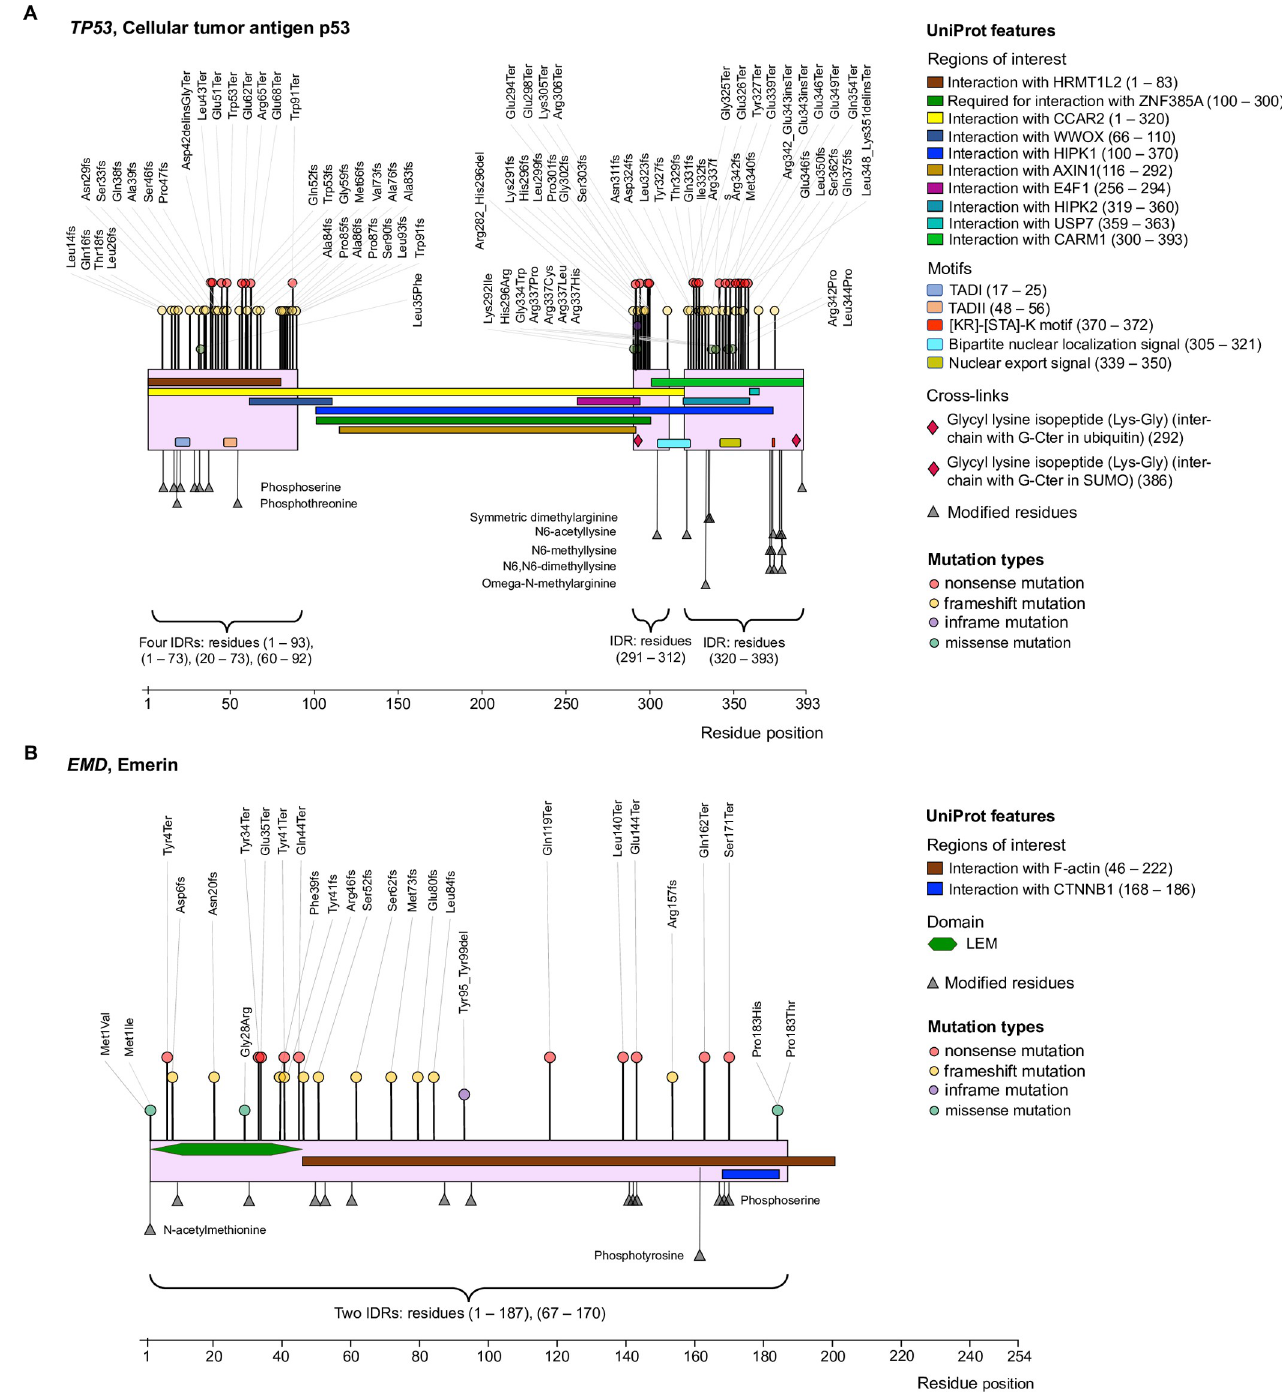
Fig 6. Illustration of mutation-intolerant IDRs with their characteristic UniProt features for two intrinsically disordered proteins. ( A ) The cellular tumor antigen protein p53 has six disordered regions; two of them were identified as intolerant to frameshift and—nonsense mutations: residues 60–92 (an effector IDR) and residues 291–312 ( not annotated with any IDR category, Table 1). These IDRs contain “regions of interest” that are involved in interactions with many partners (e.g. HRMT1L2, ZNF385A, CCAR2, WWOX, HIPK1, AXIN1, E4F1, HIPK2, USP7, CARM1), have several motifs (TADI, TADII, nuclear localization signal, [KR]-[STA]-K motif, etc.), perform interchain cross-links, and contain over 20 post-translational modification (PTM) sites or “modified residues”. All these UniProt features are identified as the characteristic features of mutation-intolerant IDR, in this study (Fig 5). Mutations affecting these IDRs (partly or in full) in p53 are primarily associated with hereditary cancer-predisposing syndrome, Li-Fraumeni syndrome, ovarian neoplasms, and familial